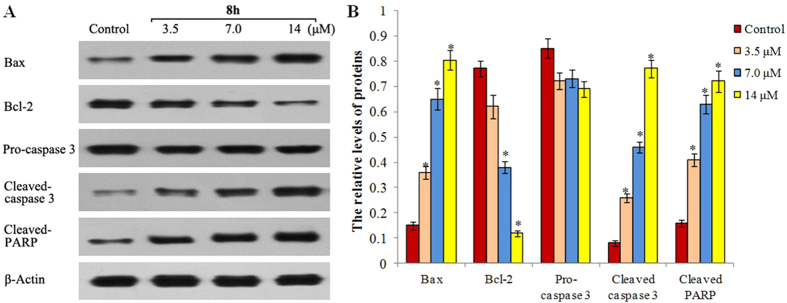
Effect of 8h on the expression of apoptosis-related proteins in SMMC-7721 cells.(A) The expression of Bax, Bcl2, caspase 3 and β-actin was examined by western blot analysis. SMMC-7721 cells were incubated with, or without, 8h at the indicated concentrations for 48 h and the levels of protein expression were detected using specific antibodies, and β-actin was used as the control. Data shown are representative images of each protein for three separate experiments. (B) Quantitative analysis: the relative levels of each protein compared to control β-actin were determined by densimetric scanning. Data are expressed as means ± SD from three separate experiments. *P < 0.01 vs control.